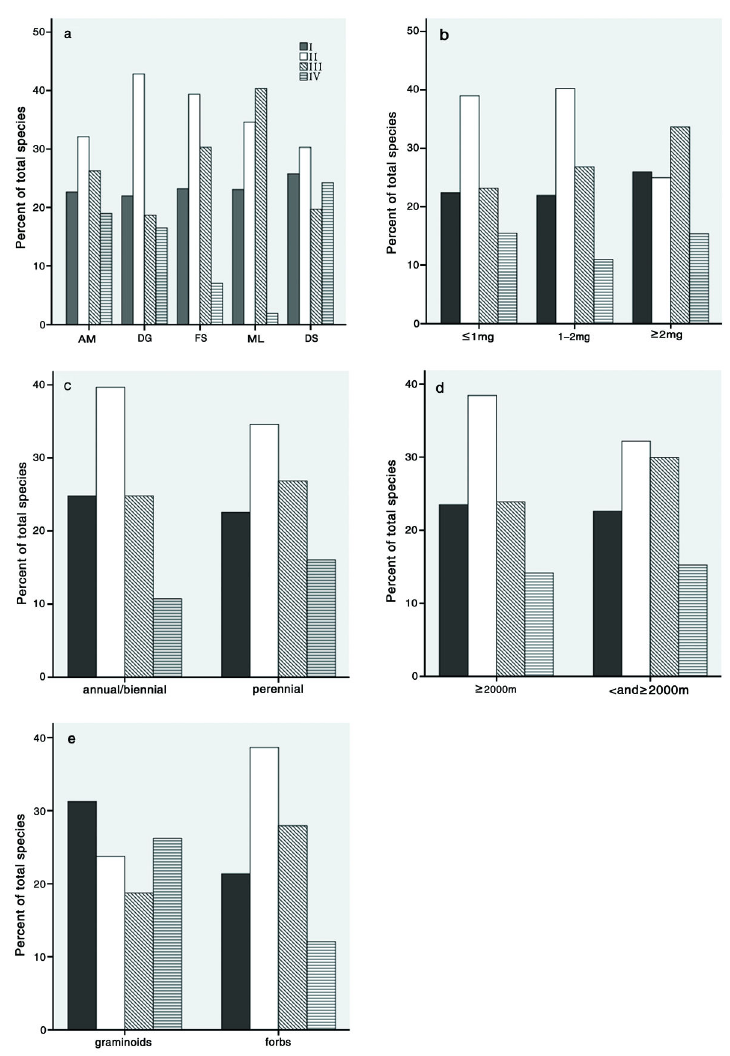
Figure 2. Relative importance of response groups I, II, III and IV when habitat (a), seed mass (b), life cycle type (c), altitudinal distribution (d) and functional group (e) are considered. I, species with a negative germination response to temperature fluctuation; II, species with a positive germination response to temperature fluctuation; III, species that cannot germinate well regardless of the temperature fluctuation; IV, species that can attain a high germination percentage regardless of the temperature fluctuation. AM: alpine/ subalpine meadow; DG: disturbed ground; FS: forest margin/scrub; ML: marshland; DS: dry sunny slope.